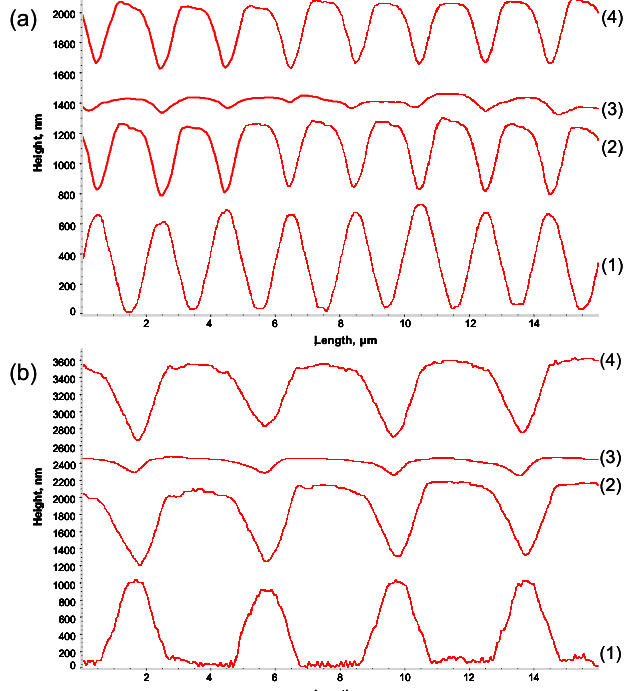
Figure 4. Atomic force microscopy (AFM) 3D topographical images with normalized Z axis in nm: ( a1 ) 2A and ( b1 ) 4B imprinted micropillars on the PETMP-TTT film surface; ( a2 , b2 ) corresponding micropillars after deformation; ( a3 , b3 ) micropillars after recovery.